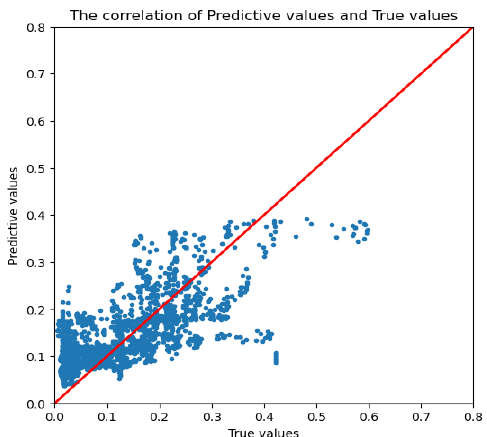
Figure 12. The distribution of CPUE values of fisheries datasets after the dataset’s expansion from approximately 2013 to 2020.